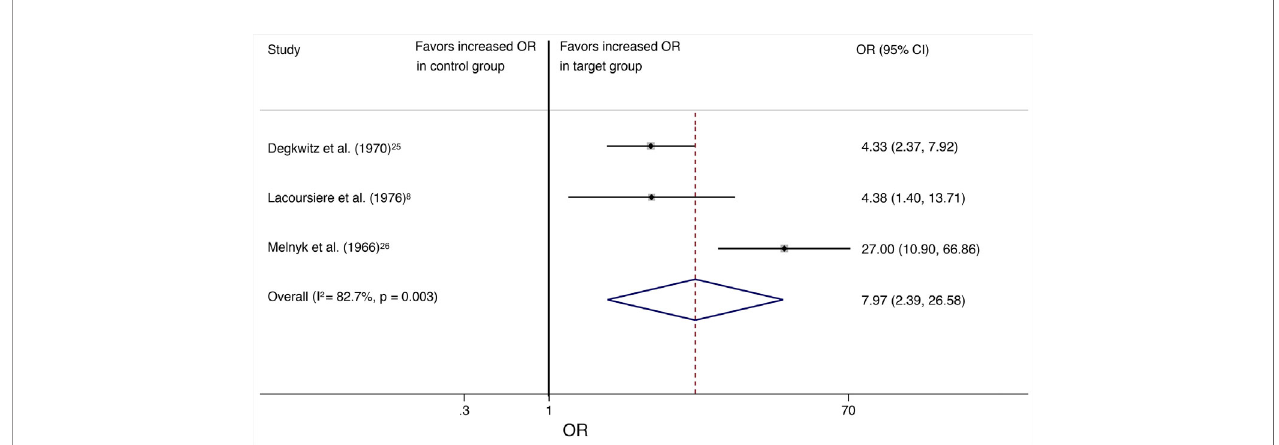
FIGURE 3 | The square data markers indicate the proportion of individuals with withdrawal symptoms in each study, with sizes re fl ecting the statistical weight of the study using random-effects meta-analysis. The horizontal lines indicate 95% CIs. The blue diamond data marker represents the overall proportion and 95% CI. The vertical dashed line shows the overall effect estimate, and the continuous line represents the line of no effect (OR =